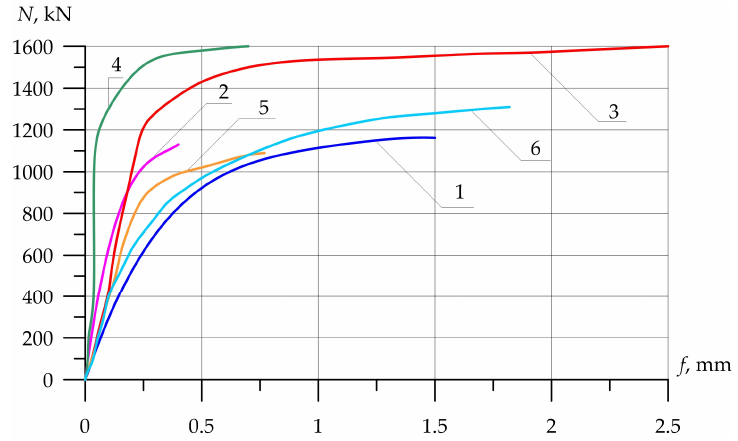
Figure 12. Comparison of experimental values of column deflections ( λ h = 10) depending on the magnitude of the load and variants for composite reinforcement with axial eccentricity e 0 = 0. The numbers on the graphs correspond to the column numbers in Table 4.